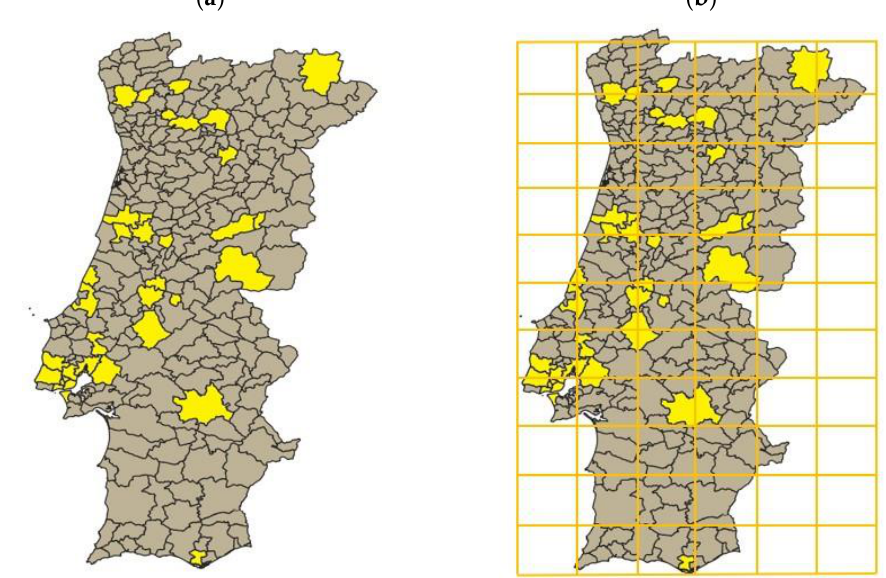
Figure 1. ( a ) Portuguese mainland counties where termite presence was reported until 1970. The counties represented in yellow are the ones where observations existed, whereas the ones in grey are the ones where no termites were reported until 1970. ( b ) Portuguese mainland divided into a 11 × 6 grid, where each resulting cell has a 50 × 50 km dimension.